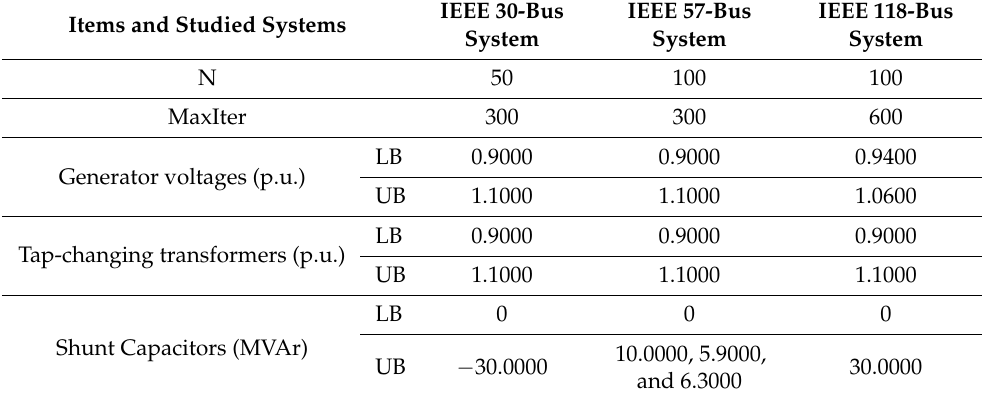
Table A1. Parameters of the ASNS and SNS for ORPD applications.